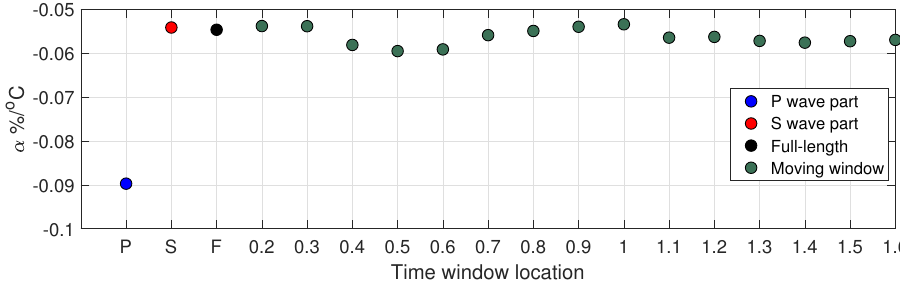
Figure 9. Calculated α = dV / V / ∆ T using different time windows. Time window locations P, S, and F represent the direct P wave, S wave, and full-length signal. Other time window locations represent a 0.2 ms wide moving window centered from 0.2 ms to 1.6 ms with a step of 0.1